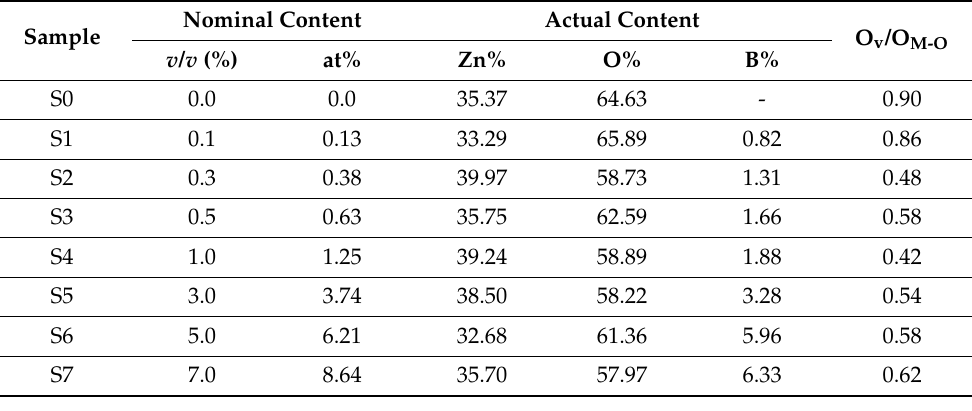
Table 3. The nominal content of B ( v / v and at. %) and the actual content of elemental Zn, O, and B in the pure and B-doped ZnO thin films.